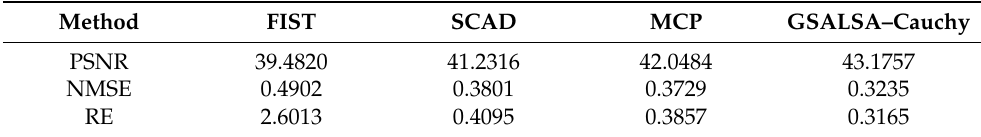
Table 4. PSNR, NMSE and RE of the corner reflector with 75%